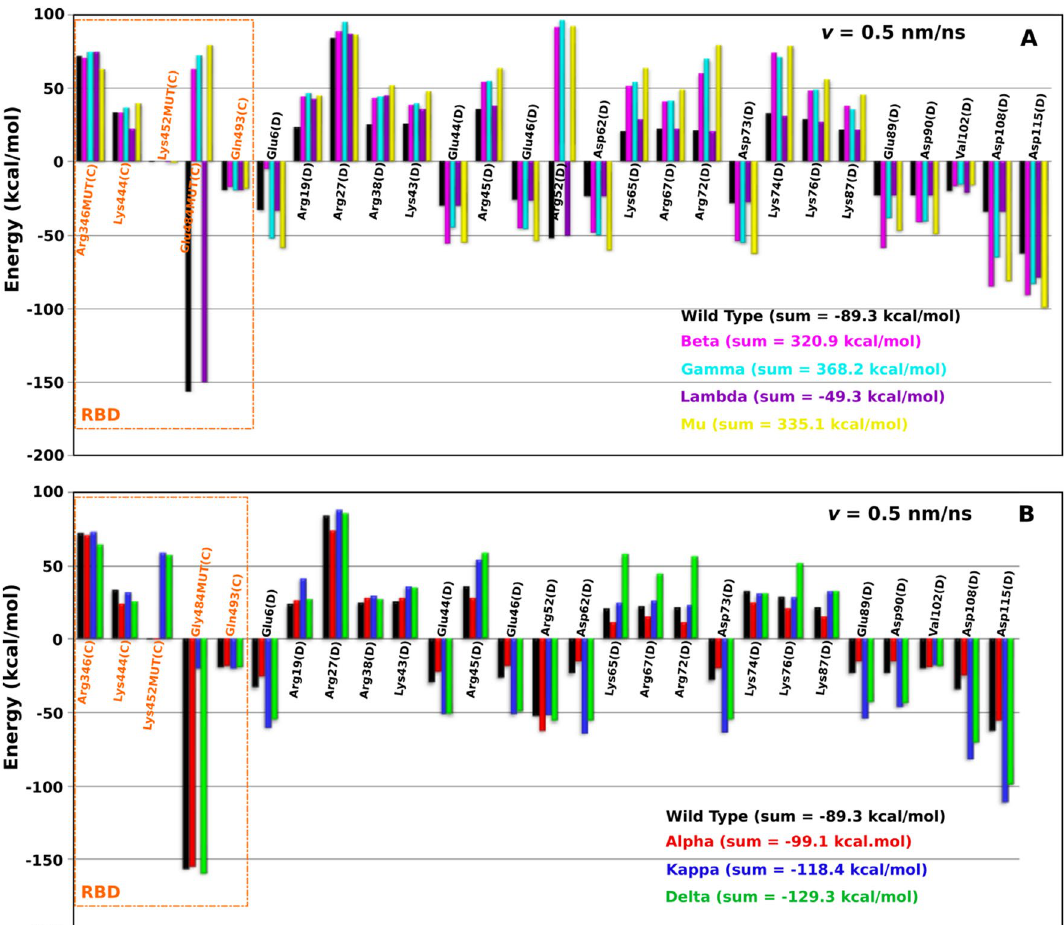
Figure 6. Total non-bonded interactions of the important residues of ( A ) H11-H4-RBD of WT and variants Beta, Gamma, Lambda and Mu, and ( B ) H11-H4-RBD of WT and variants Alpha, Kappa and Delta. The results were obtained in the time window [0, t max ] and averaged from five independent SMD runs at a pulling speed of v = 0.5